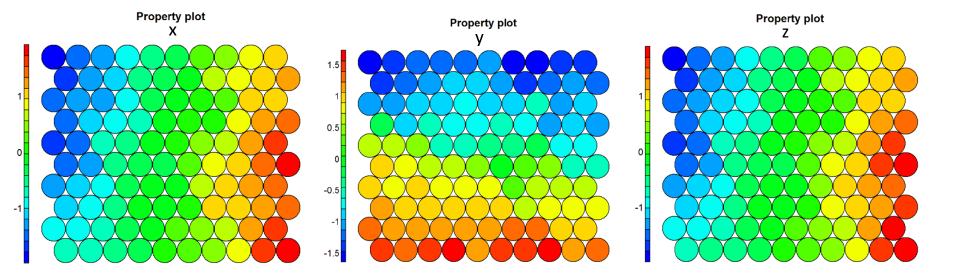
Figure 7. 1-layer Final SOMs for coordinates x, y, z,